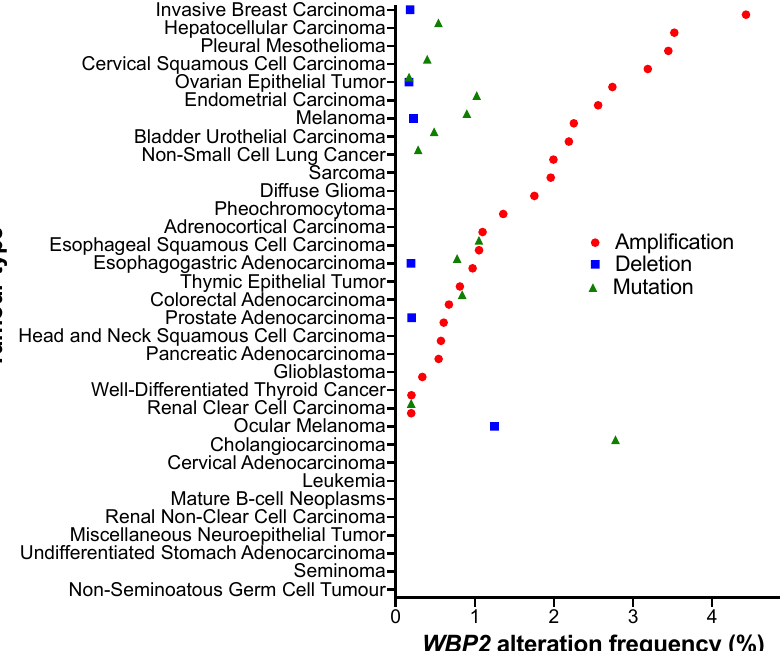
Figure 4. WBP2 copy number alteration frequency in 32 cancer types from the TCGA Pan-cancer Atlas. The x-axis shows the frequency of WBP2 alteration and the y-axis shows the tumour types found in the TCGA Pan-Cancer Atlas [75]. Each dot represents the frequency of the indicated types of WBP2 alteration; a red circled dot represents amplification, a blue squared dot represents deletion and a green triangle dot represents mutation. Data were downloaded from cBioportal [76,77] and created using GraphPad Prism.